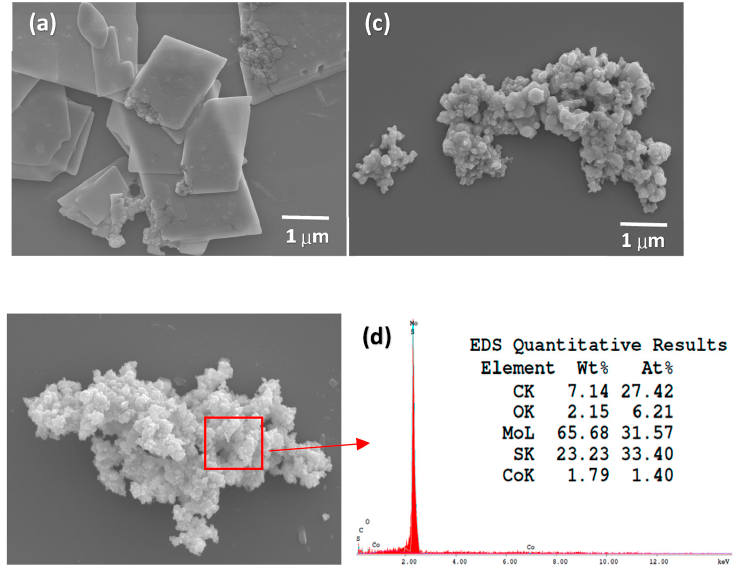
Figure 3. FESEM images of ( a ) pure MoS 2 , ( b ) 3 wt%, ( c ) 5 wt% CoO@meso–CN@MoS 2. photocatalysts, and ( d ) EDS pattern of 3 wt% CoO@meso–CN@MoS 2 .